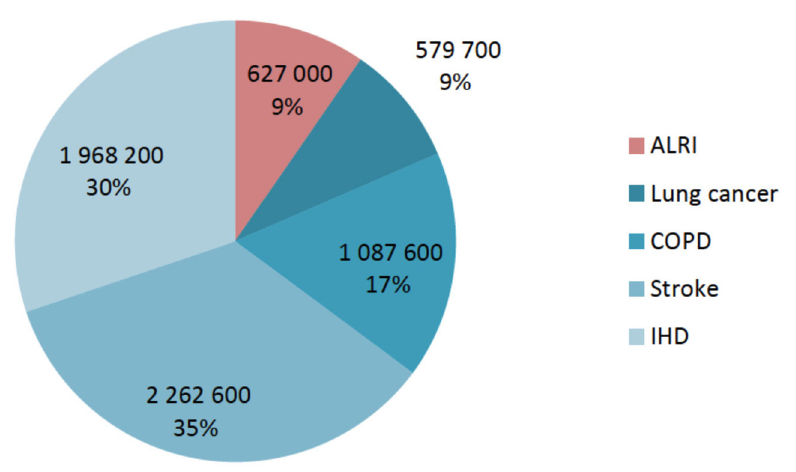
Fig. 10. – Deaths attributable to the joint effects of HAP and AAP in 2012, by disease. HAP: household air pollution; AAP: ambient air pollution; ALRI: acute lower respiratory disease; COPD: chronic obstructive pulmonary disease; IHD: ischaemic heart disease [7]. (Courtesy of